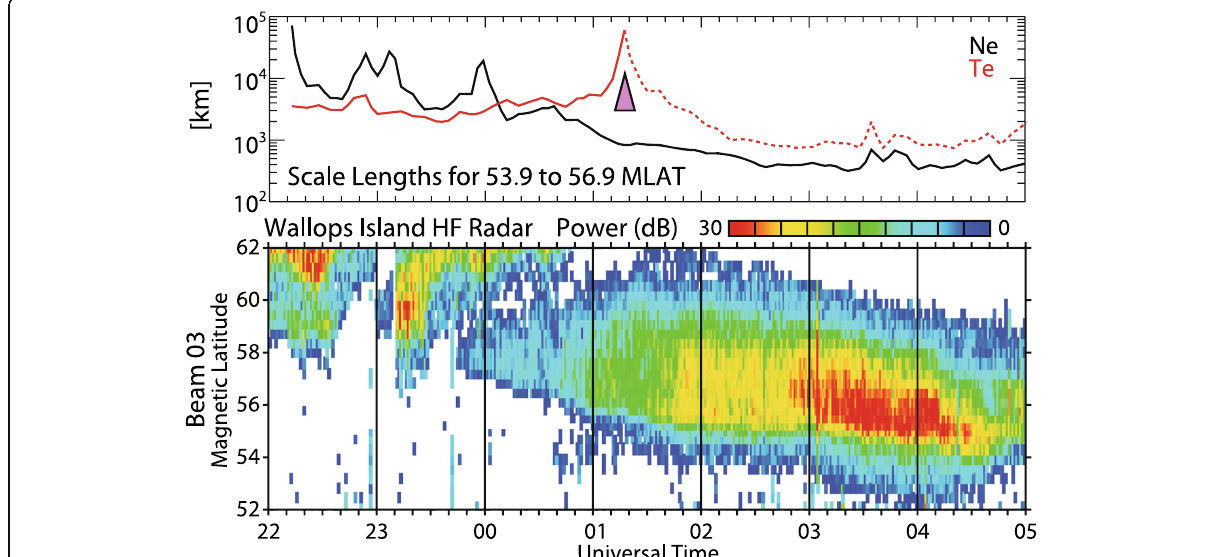
Fig. 17 The association of quiet-time sub-auroral irregularities with gradients in ionospheric electron density and temperature. The top panel shows time series of the electron density and electron temperature gradients measured by the Millstone Hill incoherent scatter radar. The pink triangle marks the time that the gradient in electron temperature reversed from poleward to equatorward, establishing favorable conditions for the TGI. The bottom panel shows a time series of backscatter power from one beam of the Wallops radar and the increase in backscatter power that followed the reversal. Adapted from Fig. 1 of Greenwald et al.